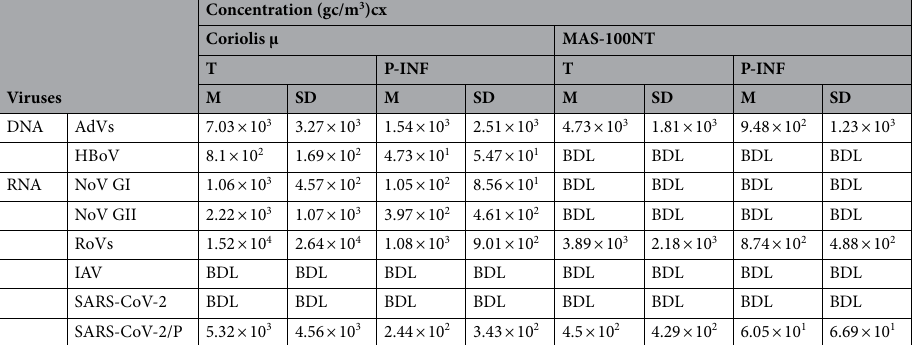
samplers, respectively (Table 3). In turn, the concentration of potentially infectious viruses revealed by v-qPCR/ v-RT-qPCR did not exceed 10 3 gc/m 3 for Coriolis μ impinger and 10 2 gc/m 3 for MAS-100NT impactor. Adenoviruses, rotaviruses and presumptive SARS-CoV-2 or other coronaviruses were the only agents detected with both samplers. The concentrations of these viruses were generally higher in samples collected with Coriolis μ impinger, especially in case of AdVs and presumptive SARS-CoV-2 or other coronaviruses (Mann–Whitney tests: p = 0.047 and p = 0.003, respectively). Regarding potentially infectious viruses, their significantly higher levels were noted for presumptive SARS-CoV-2 or other coronaviruses in Coriolis μ samples (Mann–Whitney test: p = 0.004). All detected potentially infectious viruses were observed within wastewater pumping section and their con- centrations there were the highest among examined workplaces (Tables 4). In Coriolis μ and MAS-100NT samples from wastewater pumping area, the average concentrations (and ranges) of AdVs, RoVs as well as presumptive SARS-CoV-2 or other coronaviruses were as follows: 4.41 × 10 3 gc/m 3 (1.28–7.41 × 10 3 ) and 2.12 × 10 3 gc/m 3